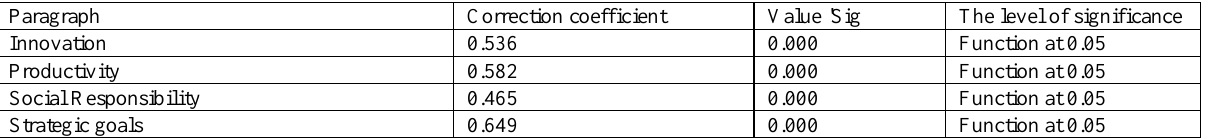
Table 18. Person's correlation transactions between participating in information and strategic goals Paragraph